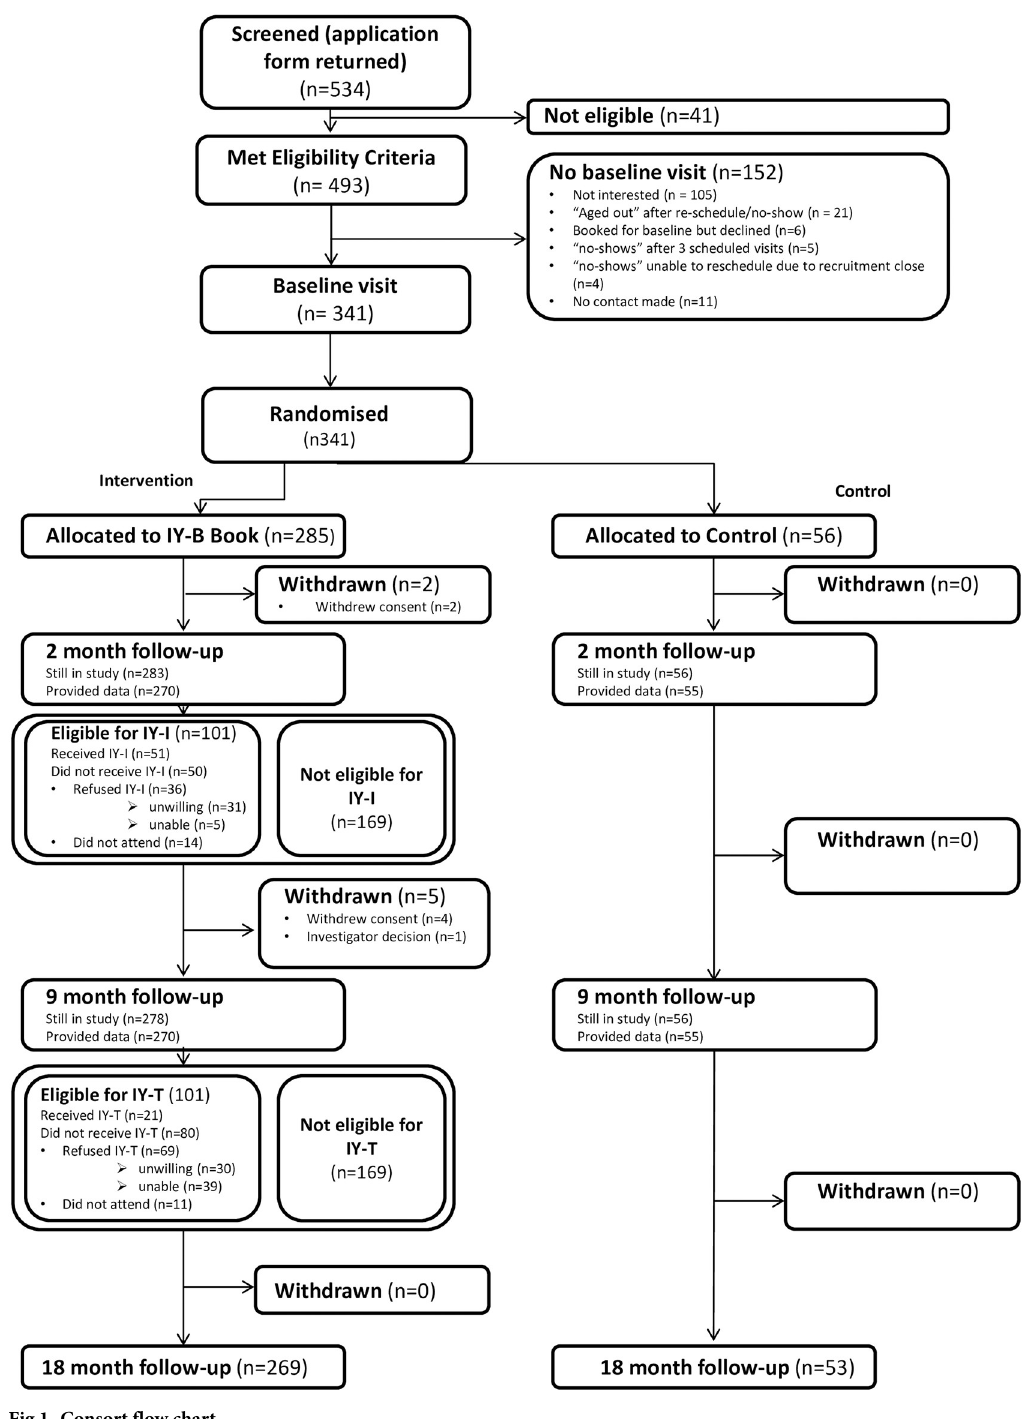
Fig 1. Consort flow